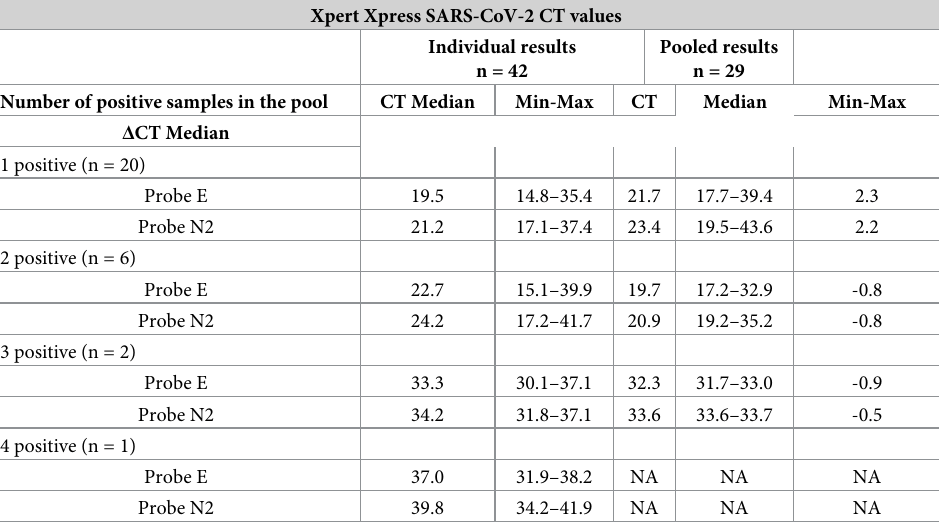
Table 2. Median CT values of individual and pooled Xpert Xpress SARS-CoV-2 probe